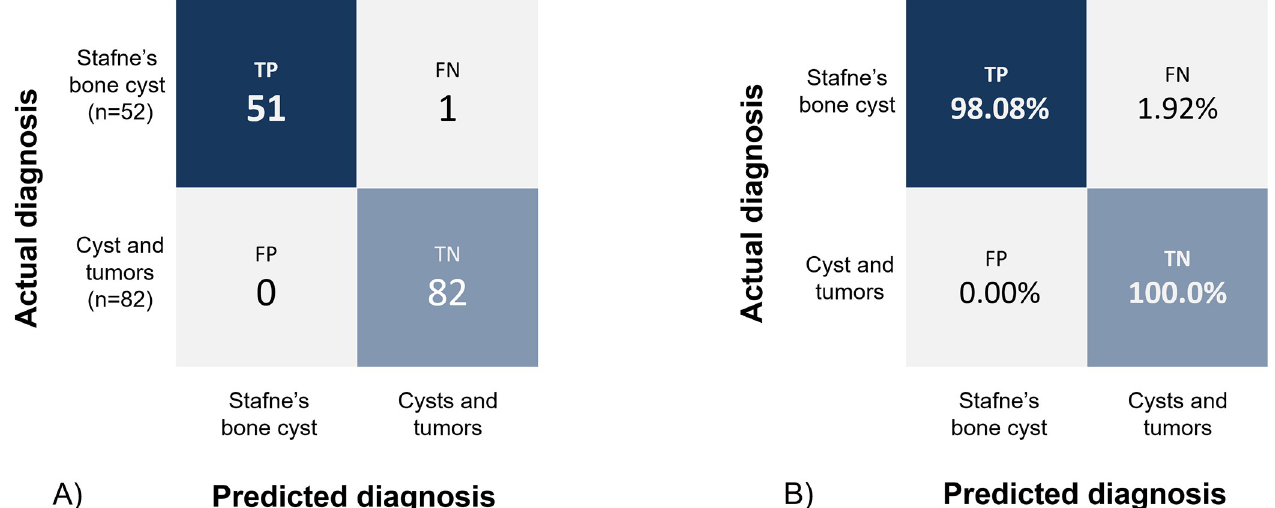
Fig 4. Confusion matrix of Stafne’s bone cavities classification from cysts and tumors using test data set. (A) true value (B) normalized value. TP: true positive, FP: False positive, FN: false negative, TN: true negative.